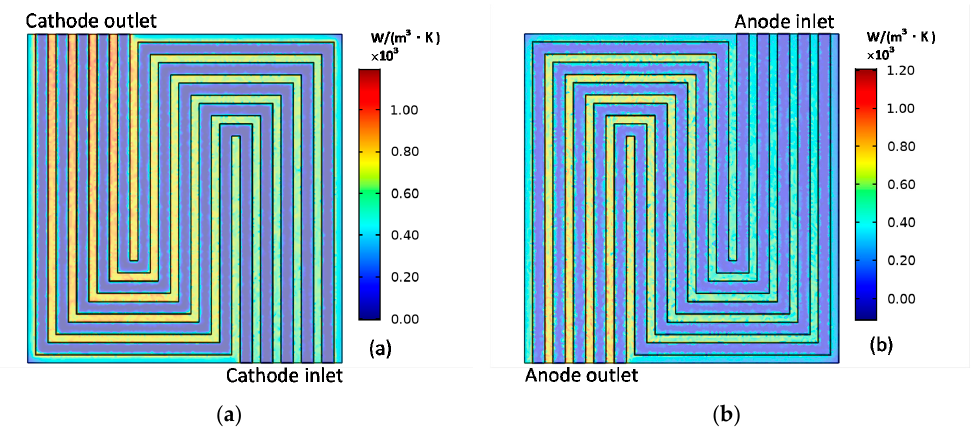
Figure 7. Cathode ( a ) entropy production and anode ( b ) entropy production caused by activation loss.